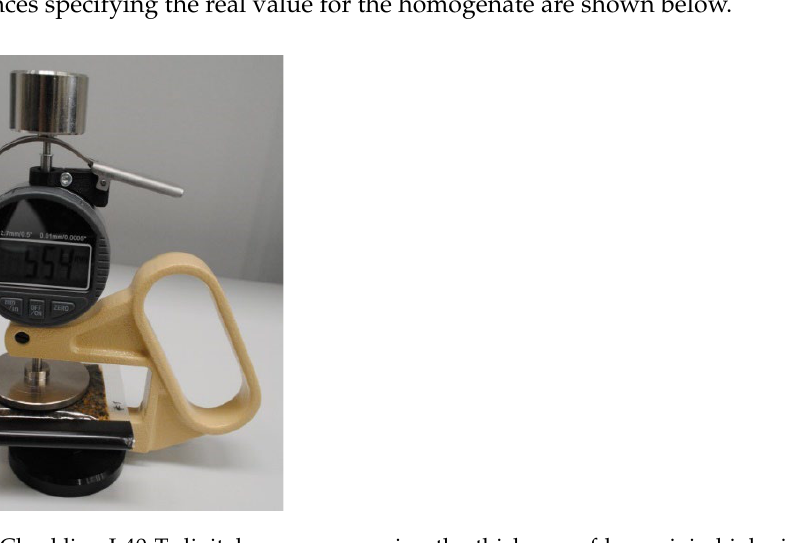
Figure 2. Checkline J-40-T digital gauge measuring the thickness of bee origin biological material samples. Table 2. Measurement results of worker bee body homogenate thickness. Sample Number